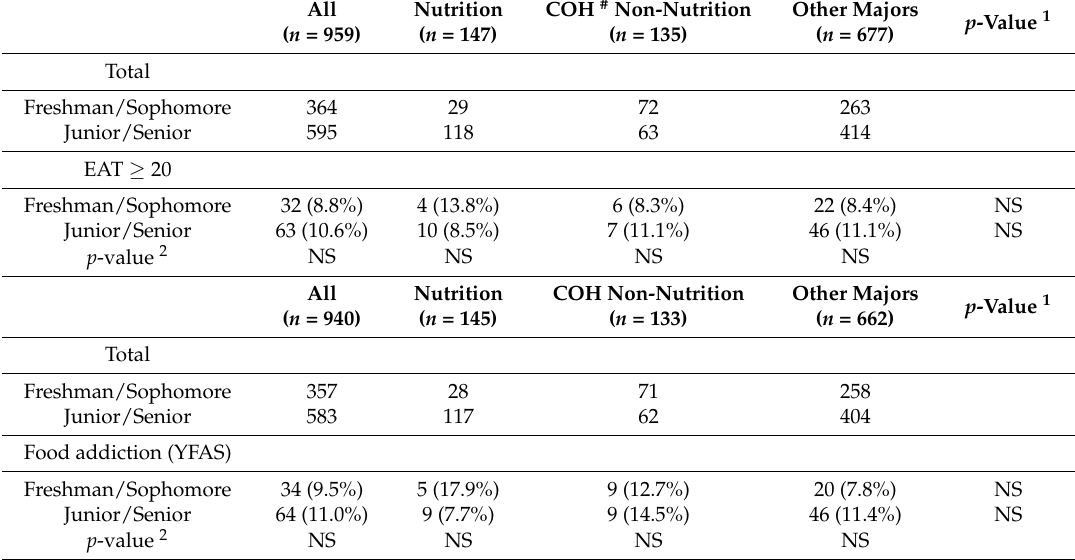
Table 4. EAT Score ≥ 20 and food addiction diagnosis by academic major year category